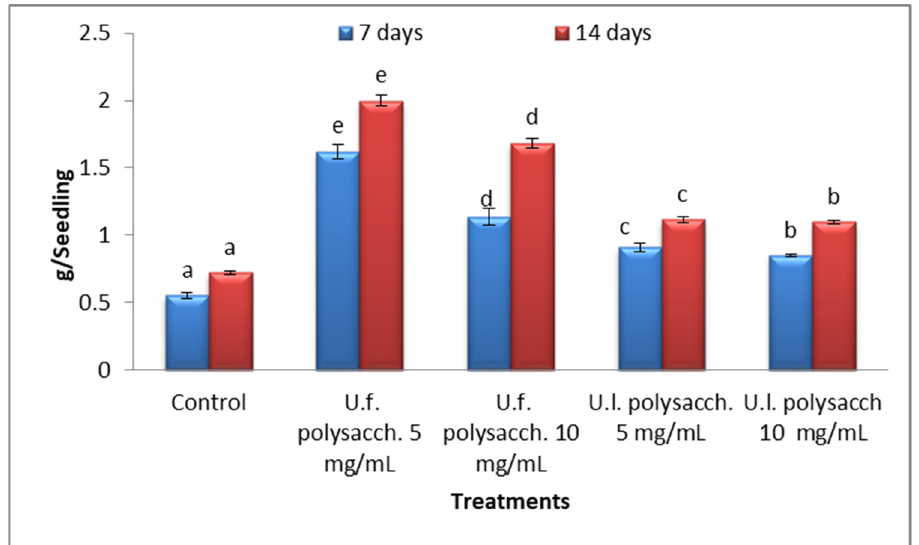
Figure 7. Effect of seed priming with different concentrations of soluble polysaccharides on the fresh weight of growing seedlings of Zea mays at 7- and 14-day intervals during the germination period. The bars represent the standard error (different letters denote the significant values among the treatments on the same day) U.f., Ulva fasciata; U.l., Ulva lactuca.